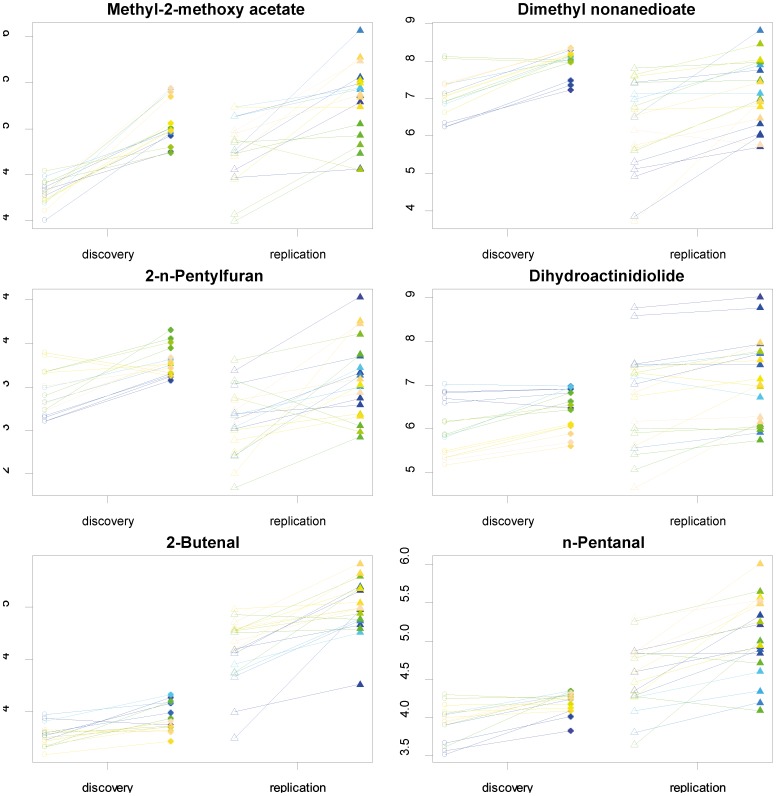
Log10 concentrations for each of the six replicated metabolites before (denoted with open symbols) and after ES (denoted with filled symbols).The paired samples are each connected with a line and pairs are coloured differently for better visualization.